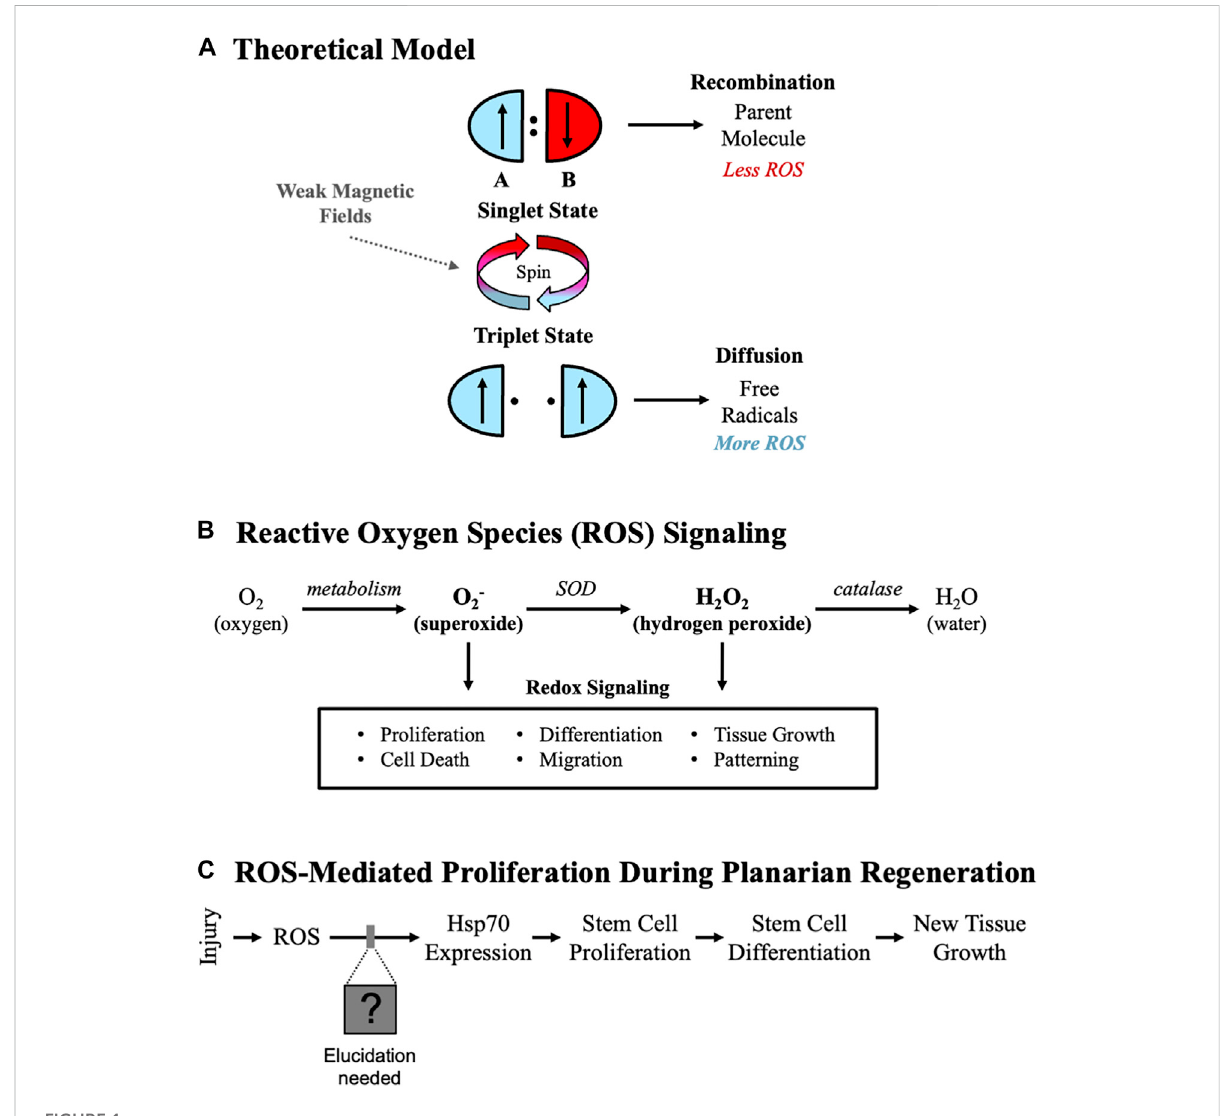
FIGURE 1 Controlling Stem Cell-Mediated Tissue Growth. (A) Theoretical model. Weak magnetic fi elds alter electron spins (represented by up or down arrows) via the radical pair mechanism, changing reactive oxygen species (ROS) levels. The antiparallel valence spins of the singlet state promote recombination, resulting in less ROS. The parallel spins of the triplet state drive diffusion, increasing ROS. (B) ROS signaling pathways. Consensus pathway from the literature for ROS signaling starting with molecular oxygen. Two of the main species known to affect cellular activities are superoxide (O2 - ) and hydrogen peroxide (H 2 O 2 ). (SOD = superoxide dismutase). (C) ROS-mediated proliferation in planarians. Experimentally derived ROS-mediated events during planarian regeneration, where changes in ROS levels affect Heat Shock Protein 70 (Hsp70), which is required for stem cell-mediated tissue growth after